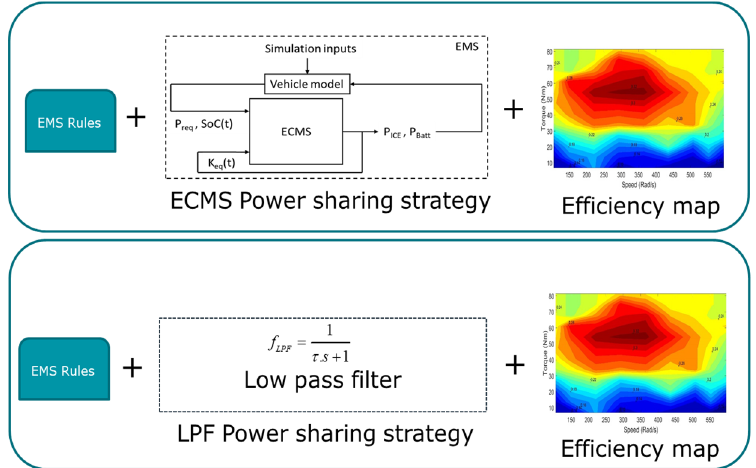
Figure 9. Overview of the considered EMS case studies, ECMS, and low pass filter (LPF) combined with RB.